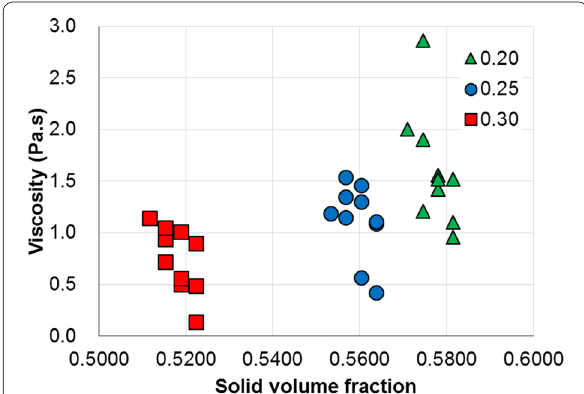
Fig. 7 Correlation of solid volume fraction and plastic viscosity with WLP replaced